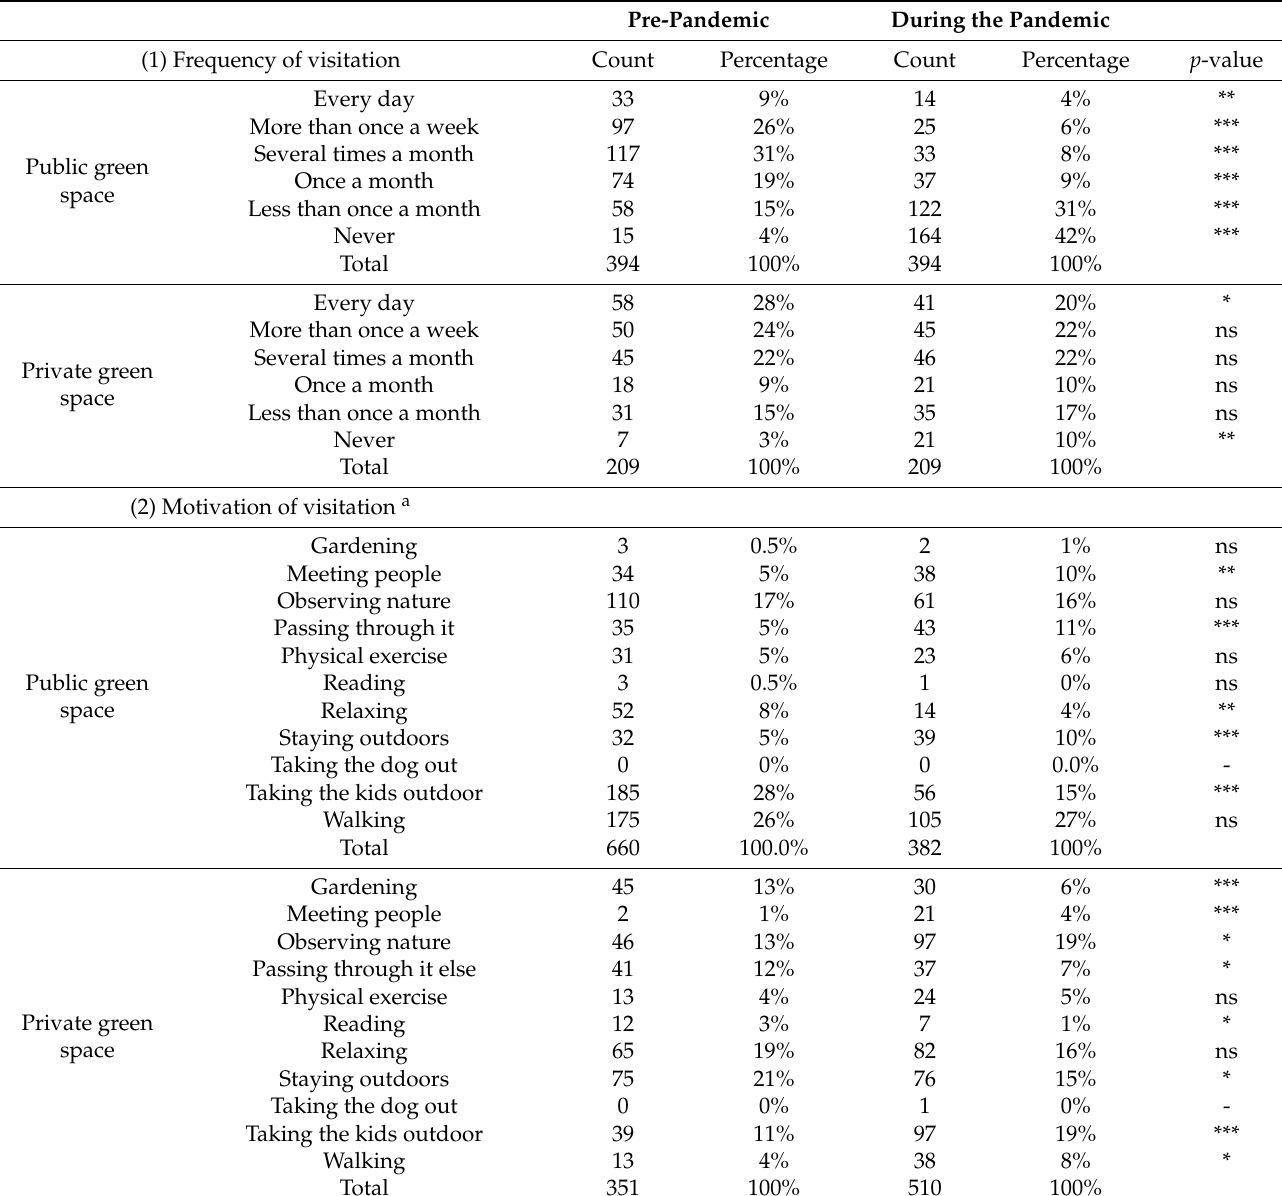
Table 1. Frequency (1) and motivation (2) of visitation of public green spaces ( n = 379 respondents, upper part in each block) and private green spaces ( n = 209 respondents, lower part in each block) before and during the pandemic. Pre-Pandemic